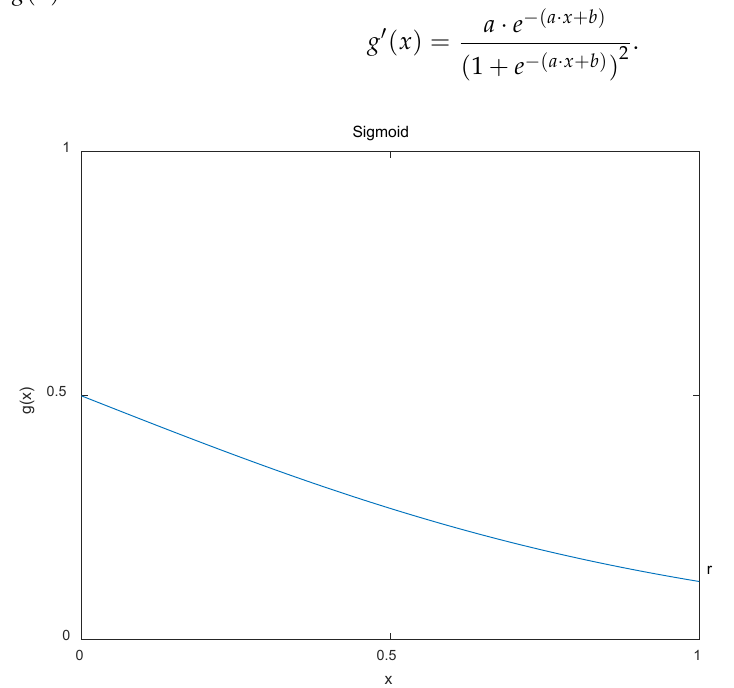
Figure 3. The flatter fragments of the activation function. The figure corresponds to the range when the activation function’s value range is [0,